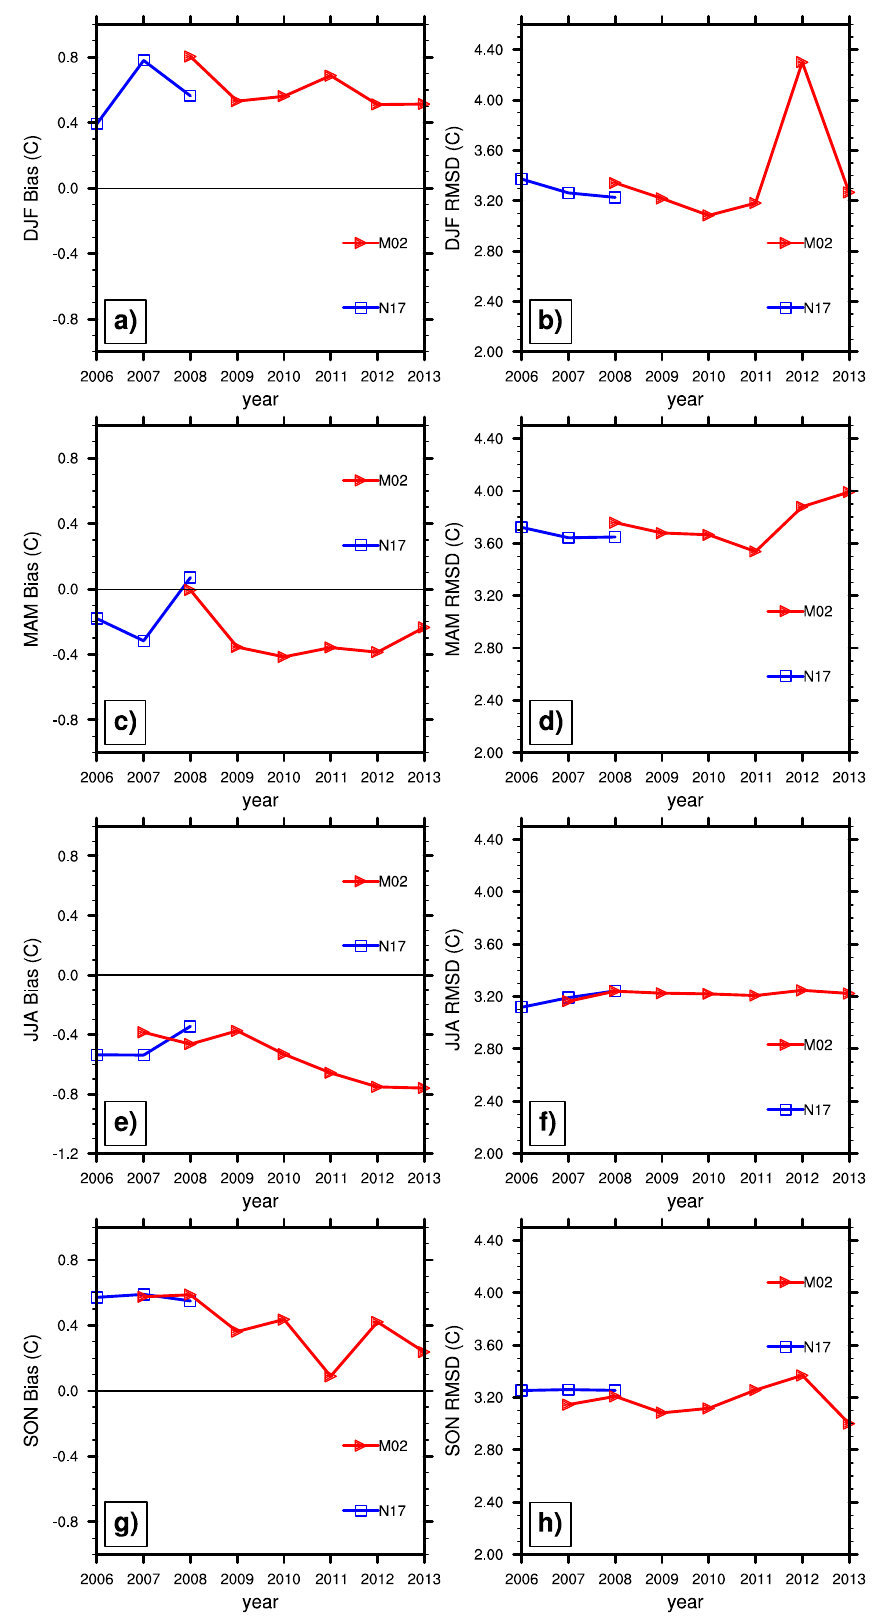
Figure 4. Seasonal mean bias and RMSD of HIRS M02 and N17 SATs (in °C). Bias is defined here as HIRS minus USCRN. Panels ( a ) and ( b ) show winter mean bias and RMSD; ( c ) and ( d ) show spring mean bias and RMSD; ( e ) and ( f ) show summer mean bias and RMSD; and ( g ) and ( h ) show fall mean bias and RMSD.